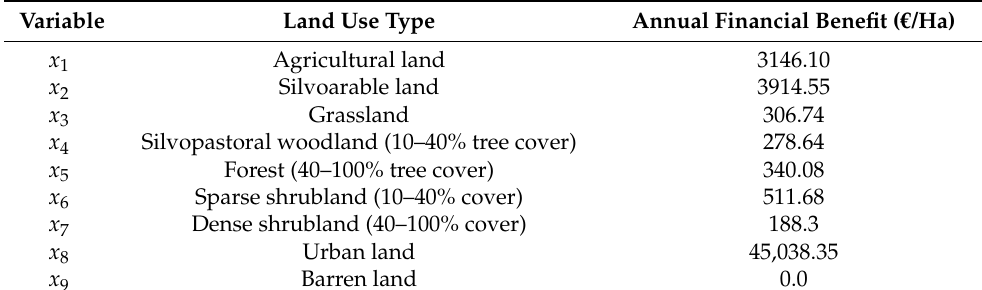
Table 3. Value (EUR/Ha) of ecosystem services per land use category in the area of the Municipality of Mouzaki, adapted from Albanis et al.